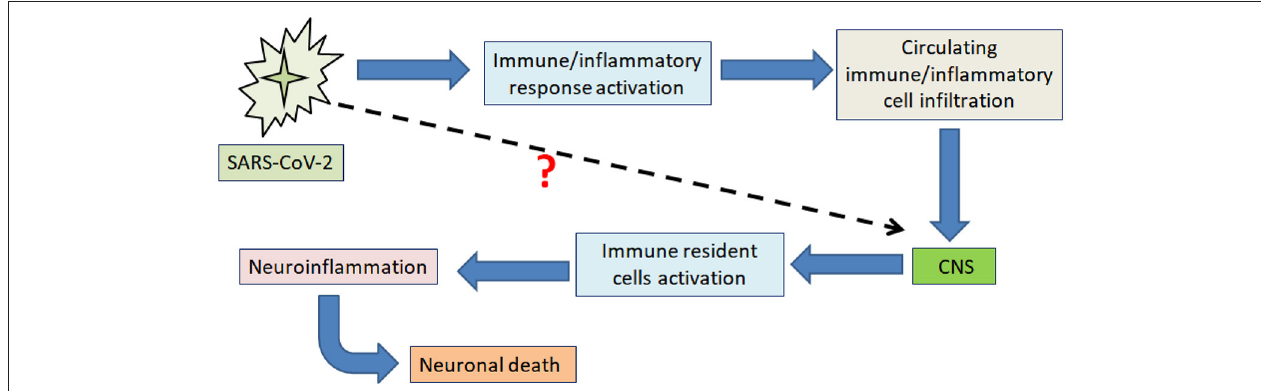
FIGURE 1 | Schematic illustration showing the main impact of SARS-CoV-2 on neuroinflammation-induced neuronal death. The figure illustrates the currently proposed mechanism through which SARS-CoV-2 produces neuroinflammation-induced neuronal death by promoting peripheral immune and inflammatory responses, impacting the CNS through immune/inflammatory cell infiltration across the